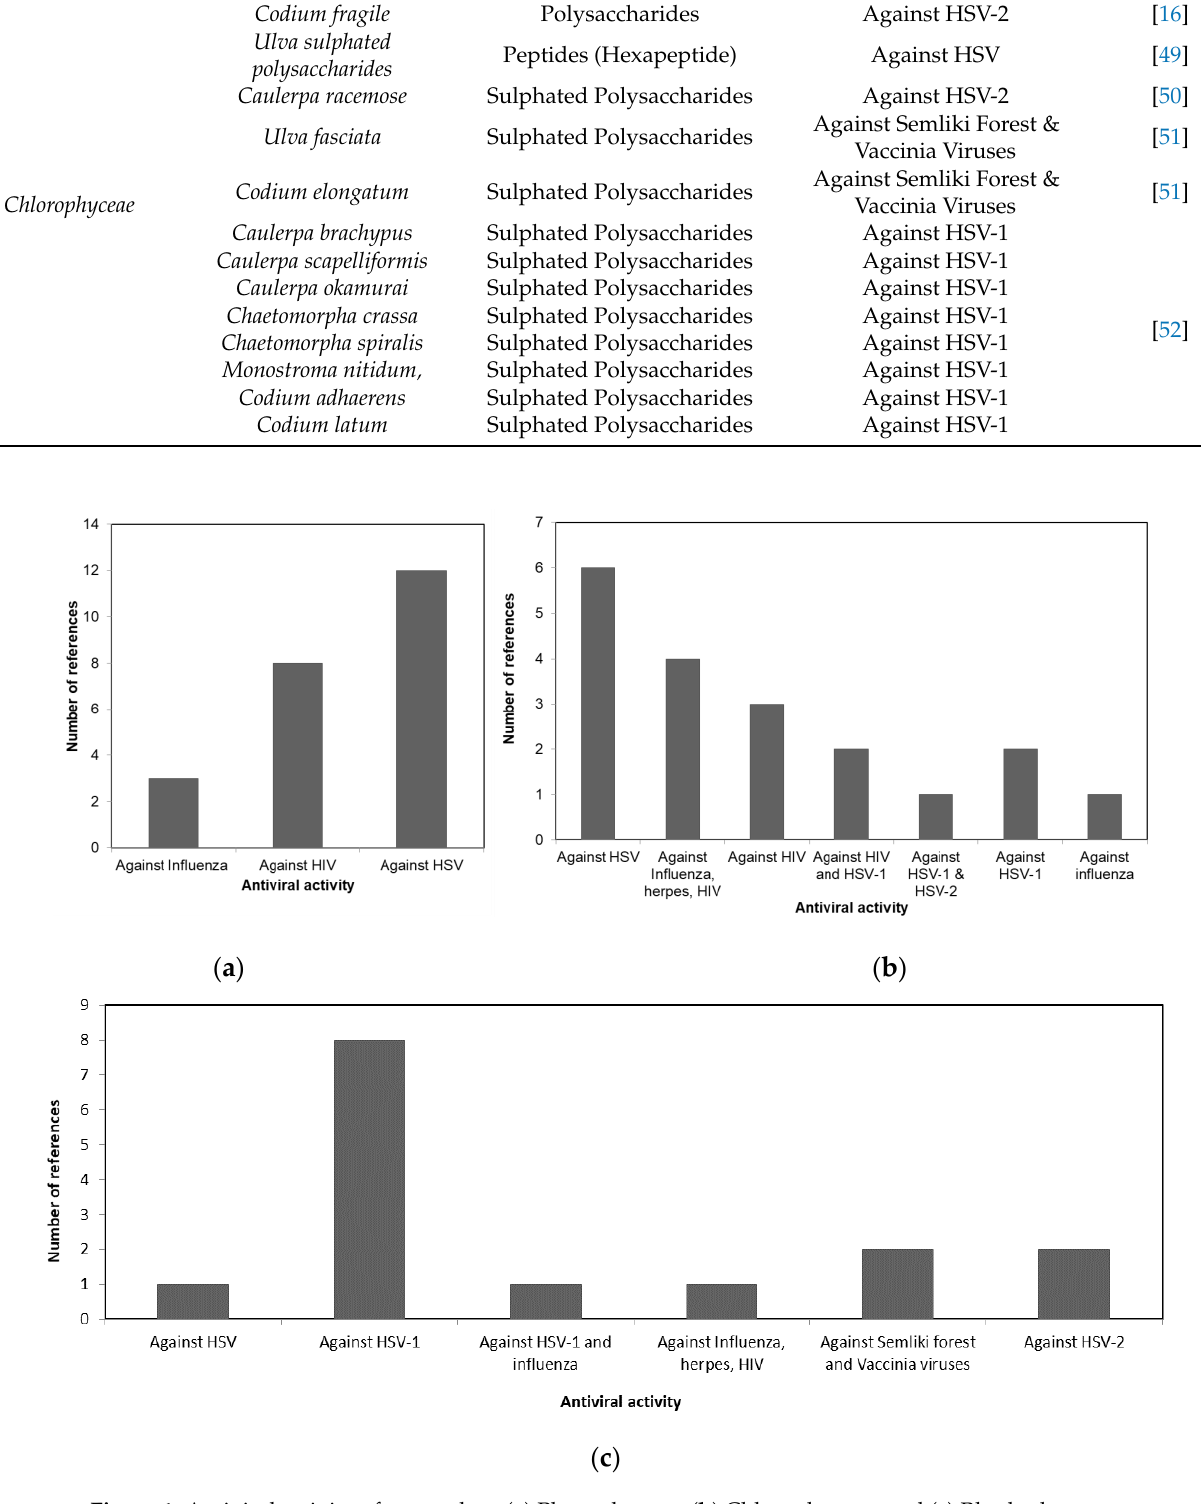
Figure 1. Antiviral activity of macroalgae ( a ) Phaeophyceae, ( b ) Chlorophyceae, and ( c ) Rhodophyceae. The mechanism of action of sulphated polysaccharides against viral infection is ex- plained as one of three ways; the first is by obstructing the virus from entering the cell. The second is by exhibiting virucidal activity. The third is by slowing down the syncytia formation. The multi-nucleate enlarged cell formed by syncytia is a result from fusion of a virally infected cell with neighboring host cells [53]. A detailed explanation of the mechanism of action of sulphated polysaccharide as antivirals has been explained by Wang et al. [54] who identified five mechanisms of action against a virus. These mechanisms were (a) direct viricidal action through the formation of an irreversible viral–polysaccharide complex, (b) inhibition of the viral adsorption by the host cell, (c) inhibition of virus uncoating, (d) hindering virus transcription inside the host cell, and (e) improvement of the host antiviral immune response by stimulation of antiviral immune factors. Recently, Hans et al. [55] elaborated on the antiviral mechanism of marine sulphated polysaccharides. They explained four different ways in which a virus infection to the host cell can be inhibited by a sulphated polysaccharide. The first mechanism is the inhibition of attachment of the virus surface to the host cell through interaction of the negatively charged sulphated polysaccharide with the positively charged virus surface instead of its interaction with the negatively charged host cell. The second mechanism involves the in- hibition of viral penetration into the host cell through the interaction between the sul- phated marine polysaccharides and the virus receptors. The third mechanism was ex- plained by the inhibition of virus uncoating inside the host cell through binding to the viral capsid that is formed inside the host cell. The final mechanism involves inhibition of the viral transcription in the host cell in case it managed to become uncoated through the interference with the replication enzymes such as reverse transcriptase enzyme. The potency of the antiviral activity of macroalgae is determined by several structural factors of the sulphated polysaccharide, first, the carbohydrate backbone: molecular weight, linearity, the flexibility of the carbohydrate chain, and the influence of hydropho- bic sites. Second, the structure of the anionic groups: carboxyl or sulphate groups, degree of sulphation, and the distribution of sulphate groups in the carbohydrate backbone [56]. The same was confirmed by Adhikari et al. [34]. They claim that sulphated polysac- charide’s antiviral activity depends on its molecular weight, constituent sugar, and the sulphation degree where low or absent sulphation indicates weak or non-antiviral activ- ity.